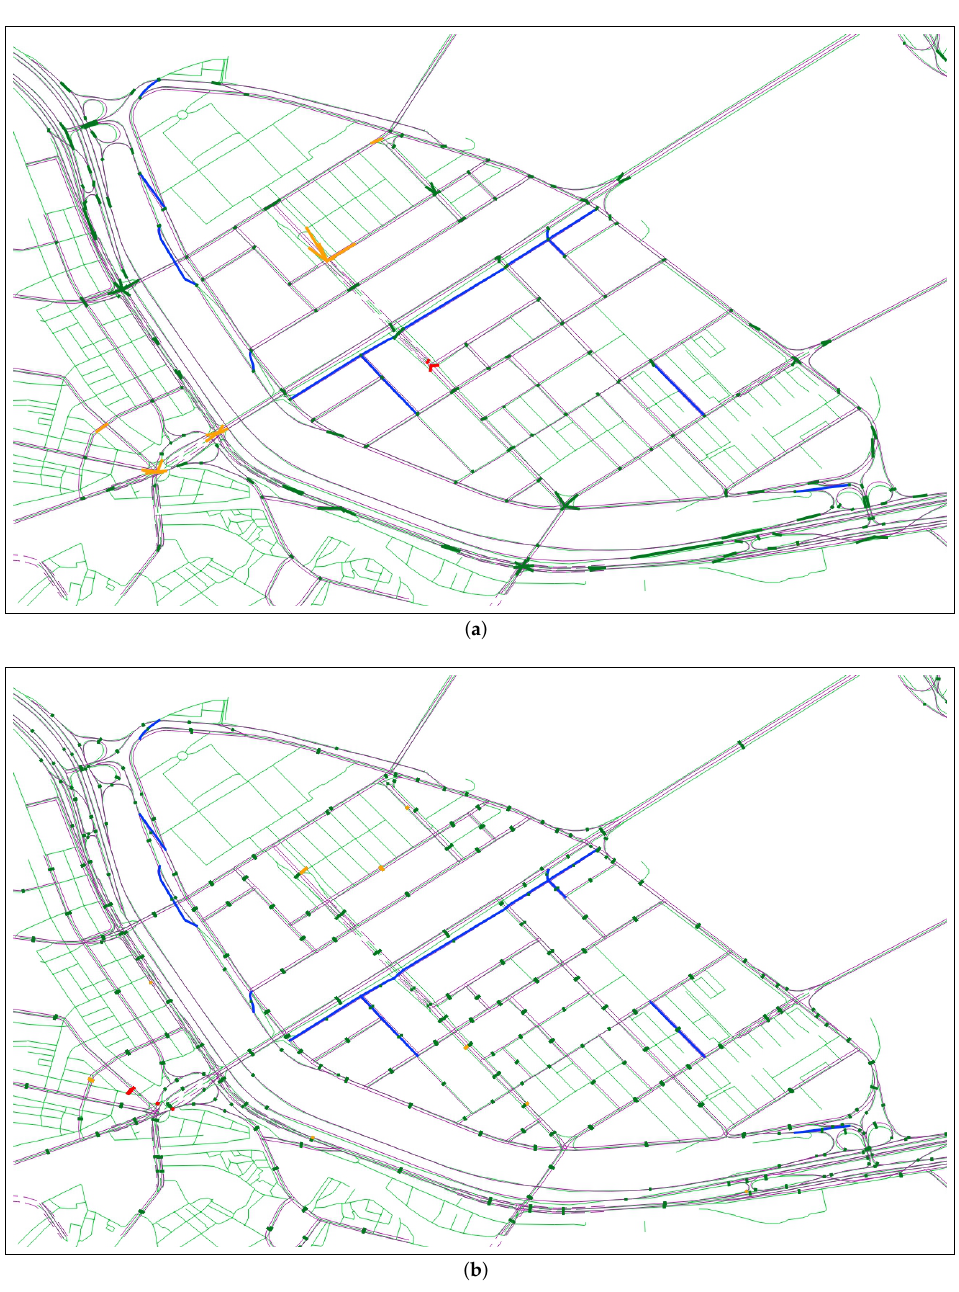
Figure 19. Matching results of APSG scheme: ( a ) Node matching and ( b ) edge